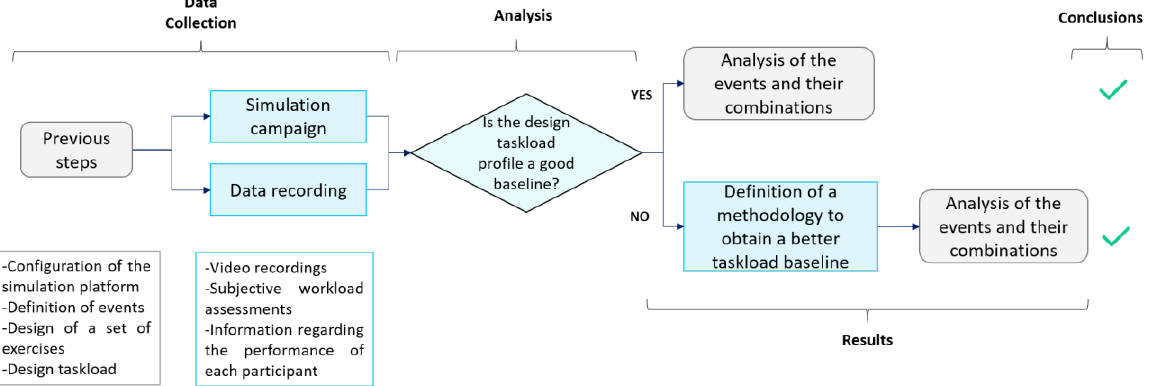
Figure 1. Methodology to follow to obtain an event-based taskload profile of reference and to study ATC events and their combinations.